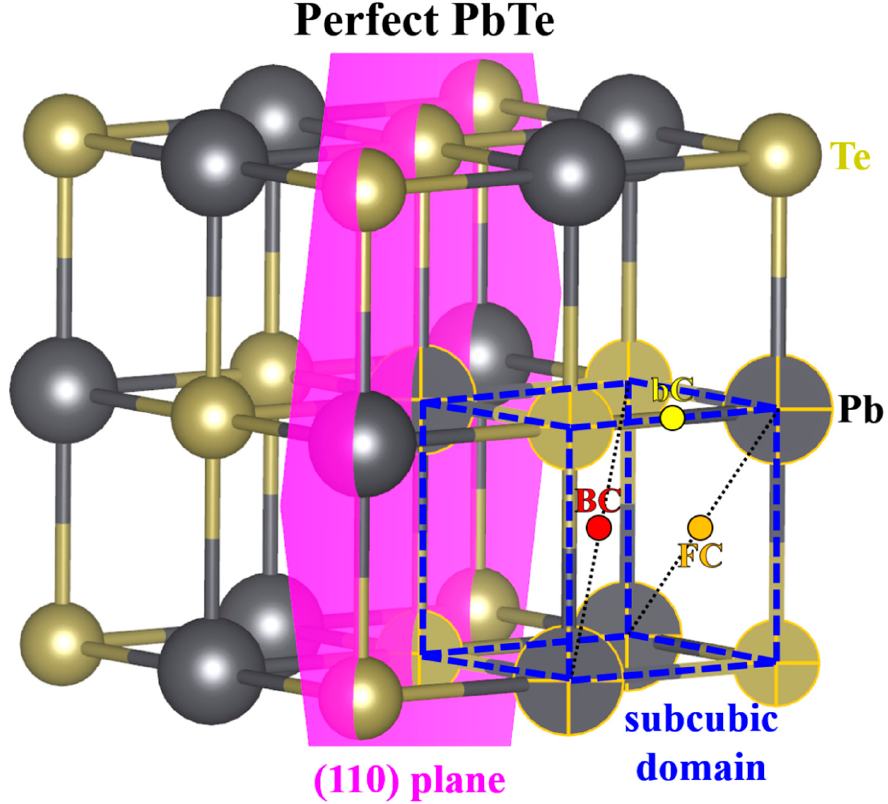
Figure 2. Rock-salt atomic structure of perfect PbTe. The black and gold balls indicate Pb and Te atoms, respectively. The blue dashed lines represent the defined subcubic domain. Its high-symmetry positions consist of the bond center (bC, yellow dot) of Pb − Te, the face center (FC, orange dot), and the body center (BC, red dot). The thin black dotted lines inside the subcubic domain are a guide to the eye for the high-symmetry locations. The violet plane is a (110) plane.